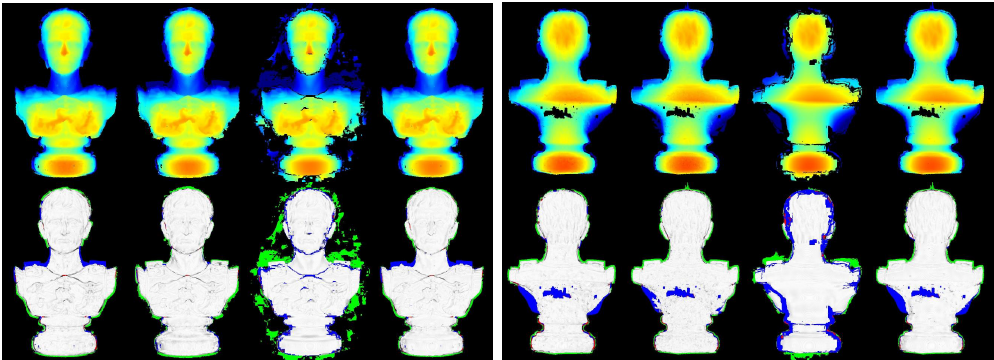
Figure 14. Colorized depth maps and visualized (relative) depth errors for the front and back sample views. For each view, from left to right are the estimated depth maps ( top ) and the relative depth errors ( bottom ) from MVS, MVE, SMVS and our approach respectively.